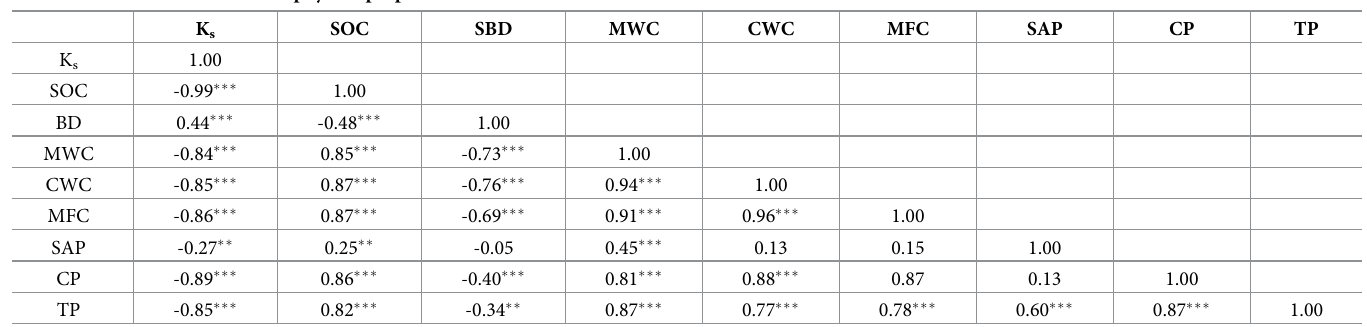
Table 2. Correlation between soil physical